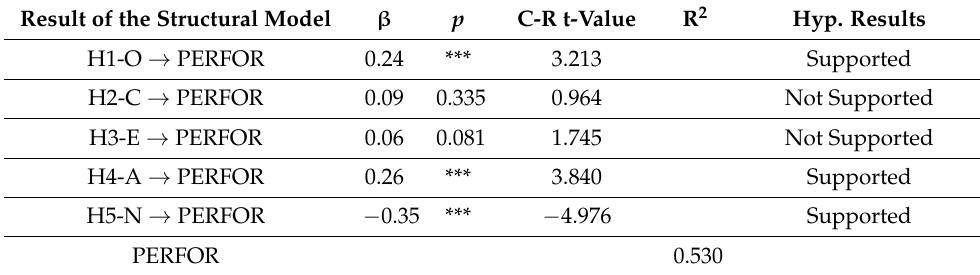
Figure 2. The structural model (*** p < 0.001). Table 3. Testing the research hypothesis.